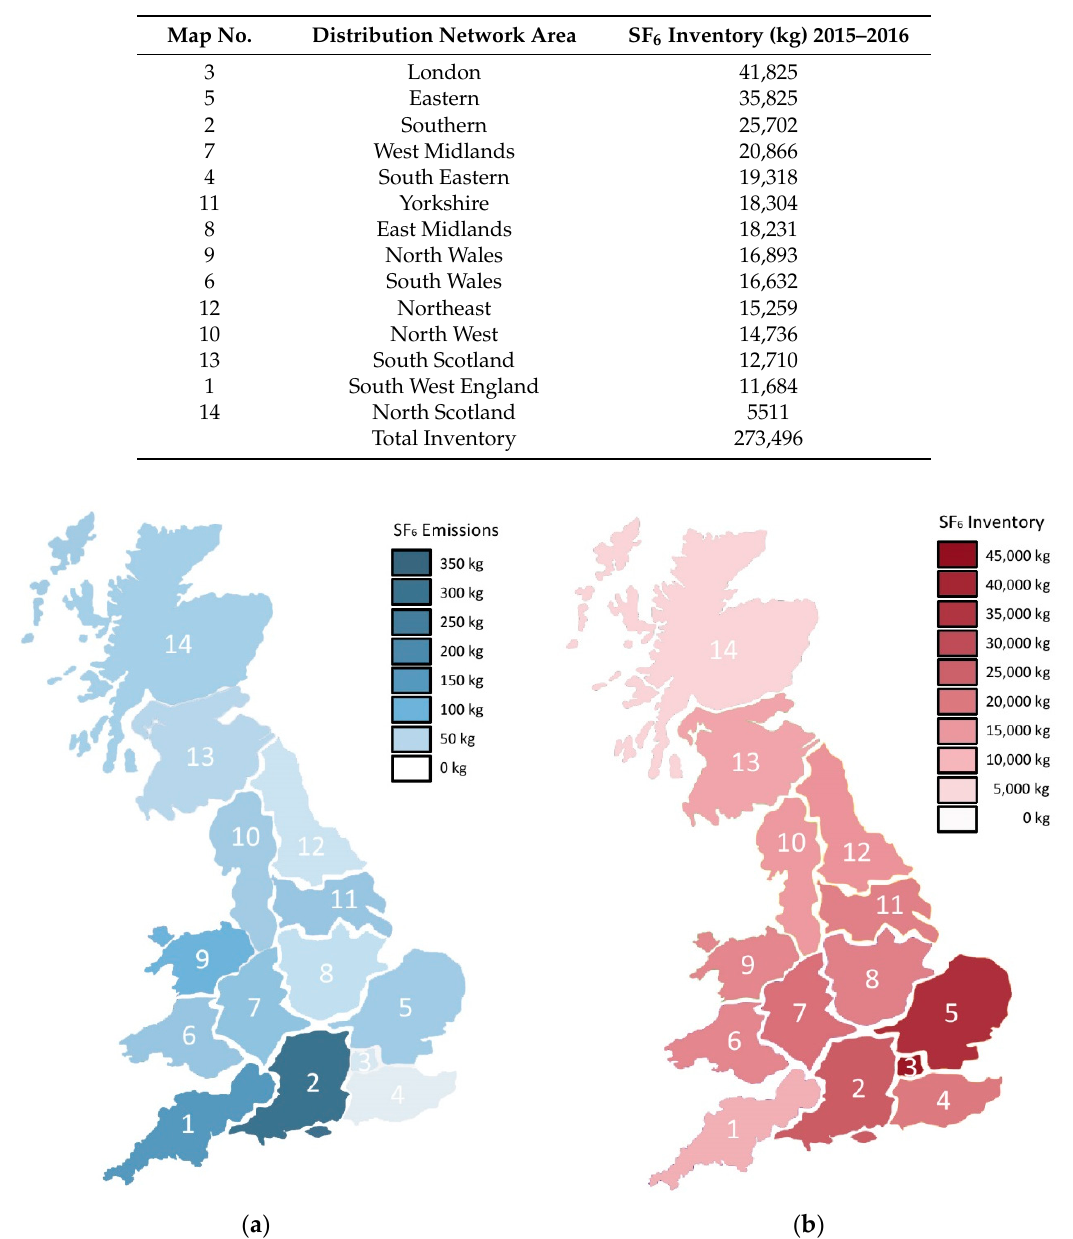
Figure 2. ( a ) Calculated annual average SF 6 emissions (kg) of the distribution network in Great Britain (between 2010 and 2016); and ( b ) SF 6 inventory (kg) of the distribution network in Great Britain (2015–2016).